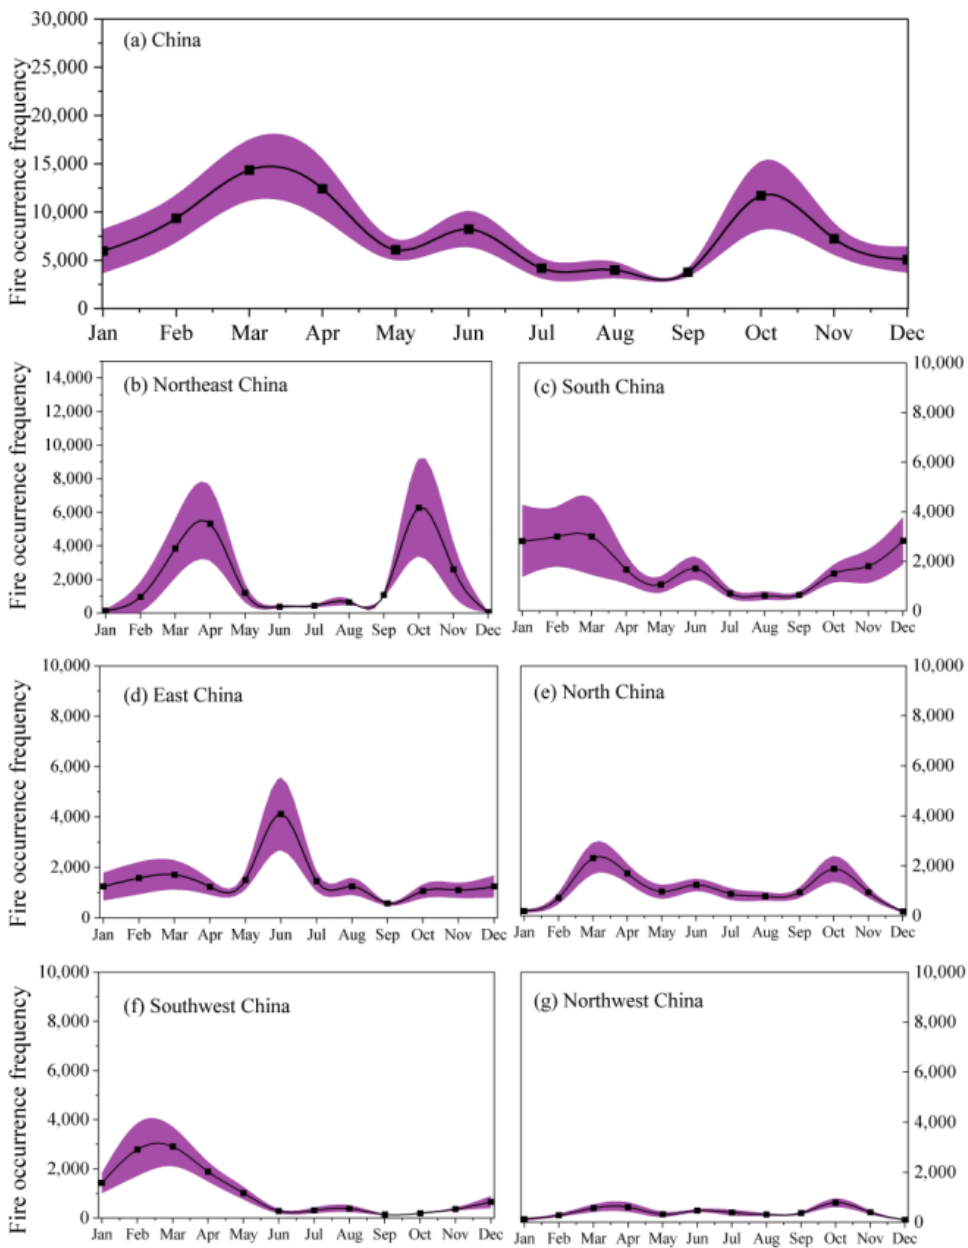
Figure 4. The monthly average number of active fire occurrence frequencies and its 95% confidence interval (purple area) in ( a ) China, ( b ) Northeast China, ( c ) South China, ( d ) East China, ( e )